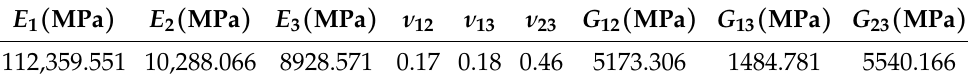
Table 6. Material parameters of homogenized